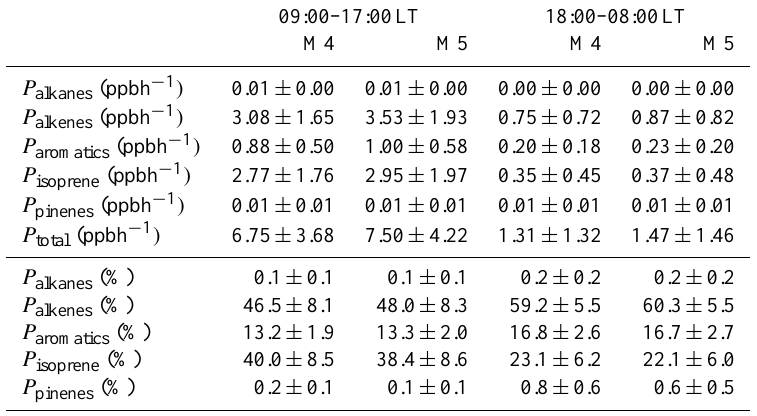
Table 4. The average of production rates and corresponding percentages of formaldehyde from different precursors in the model simulations for the full control period (M4) and the scenario without the control measures (M5). All the values are presented as average ± SD.